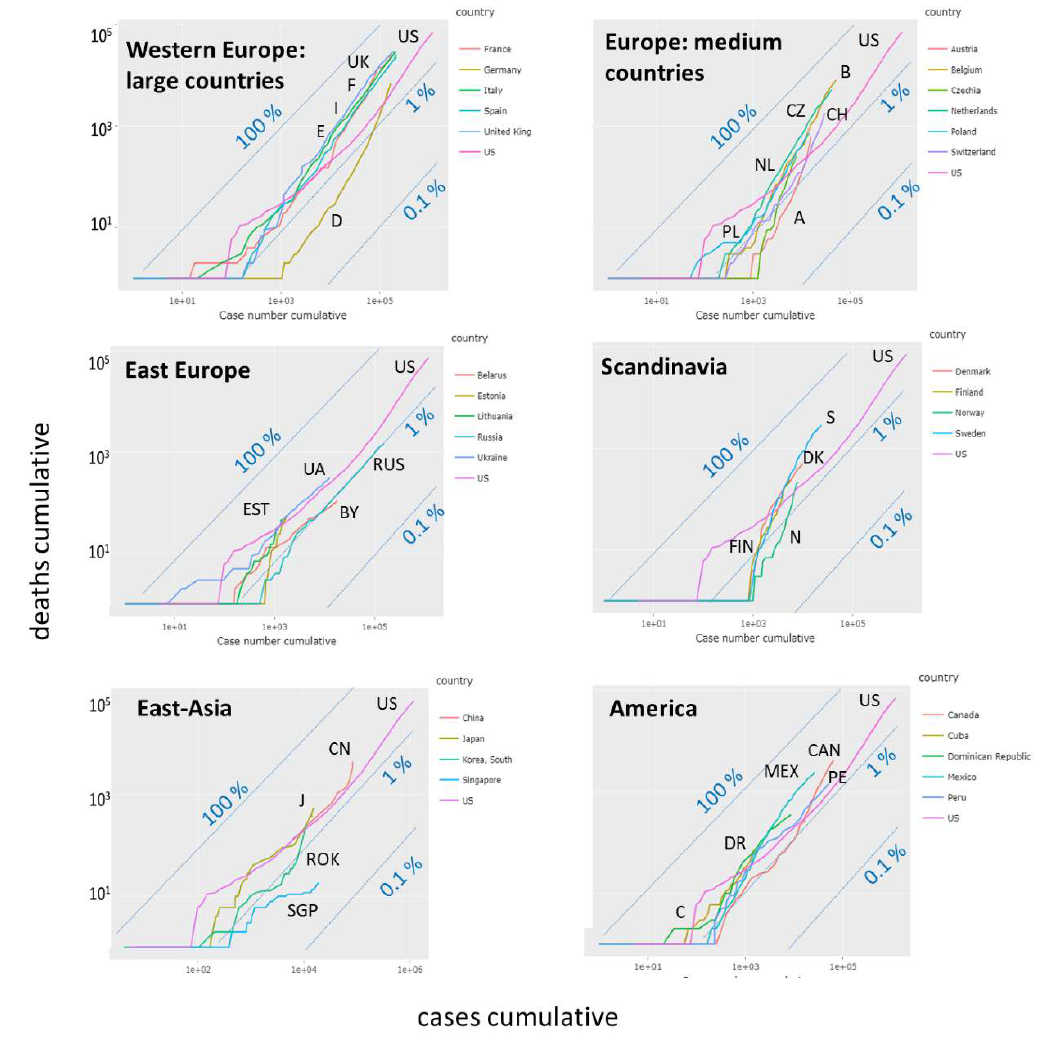
Figure 9. Mortality trajectories show cumulative number of deaths versus cumulative number of infections. The diagonal line (y = x) refers to 100%, parallel lines to 1% and 0.1% (number of deaths per 100 cases). The mortality trajectory of the US is shown in all plots for comparison.